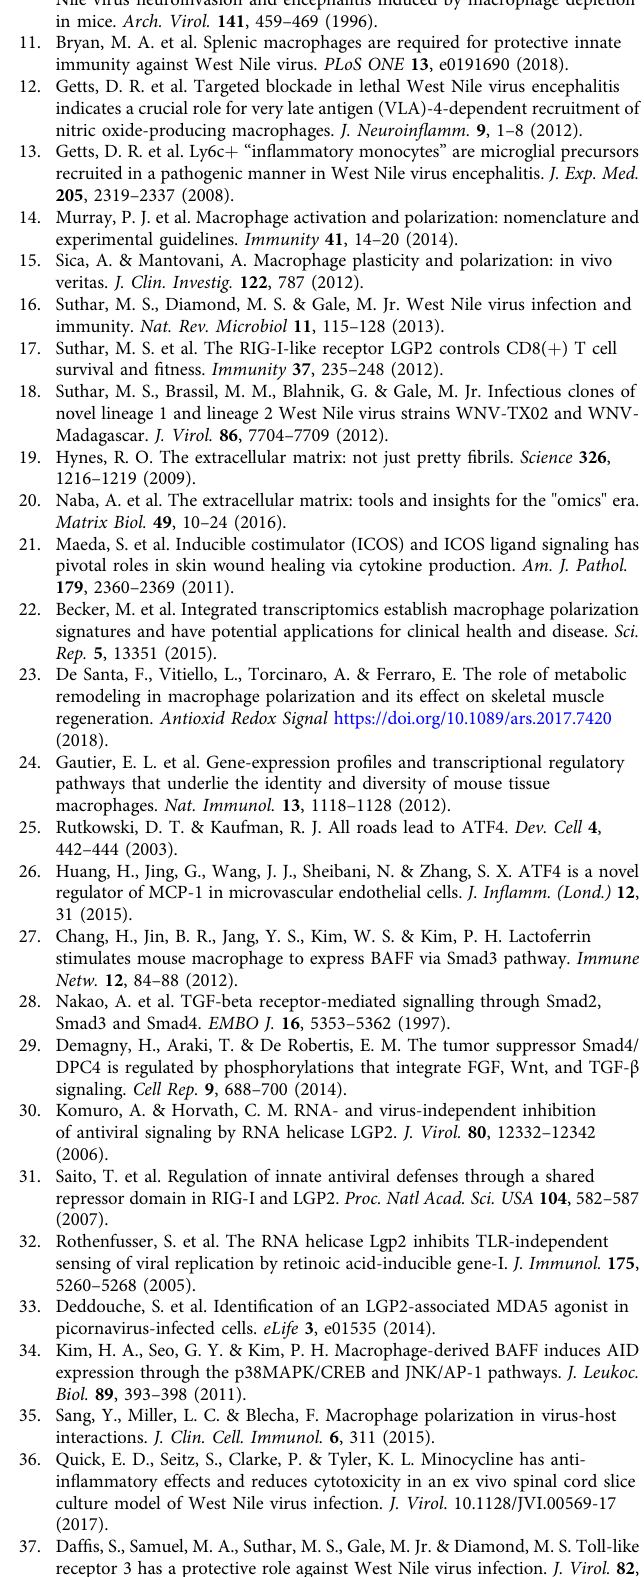
Figure 6b, c: percentage and count comparisons were two-tailed unpaired Welch ’ s t -test between the genotypes for each organ and infection condition (Tables 2, 3). Figure 6d: PFU comparisons were one tailed t -tests between genotypes for each organ. Spleen p = 0.2309 t = 1.702 DF = 2; Brain p = 0.0052 t = 13.88 DF = 2. Figure 6e Comparisons were two-tailed unpaired Holm-Sidak method with